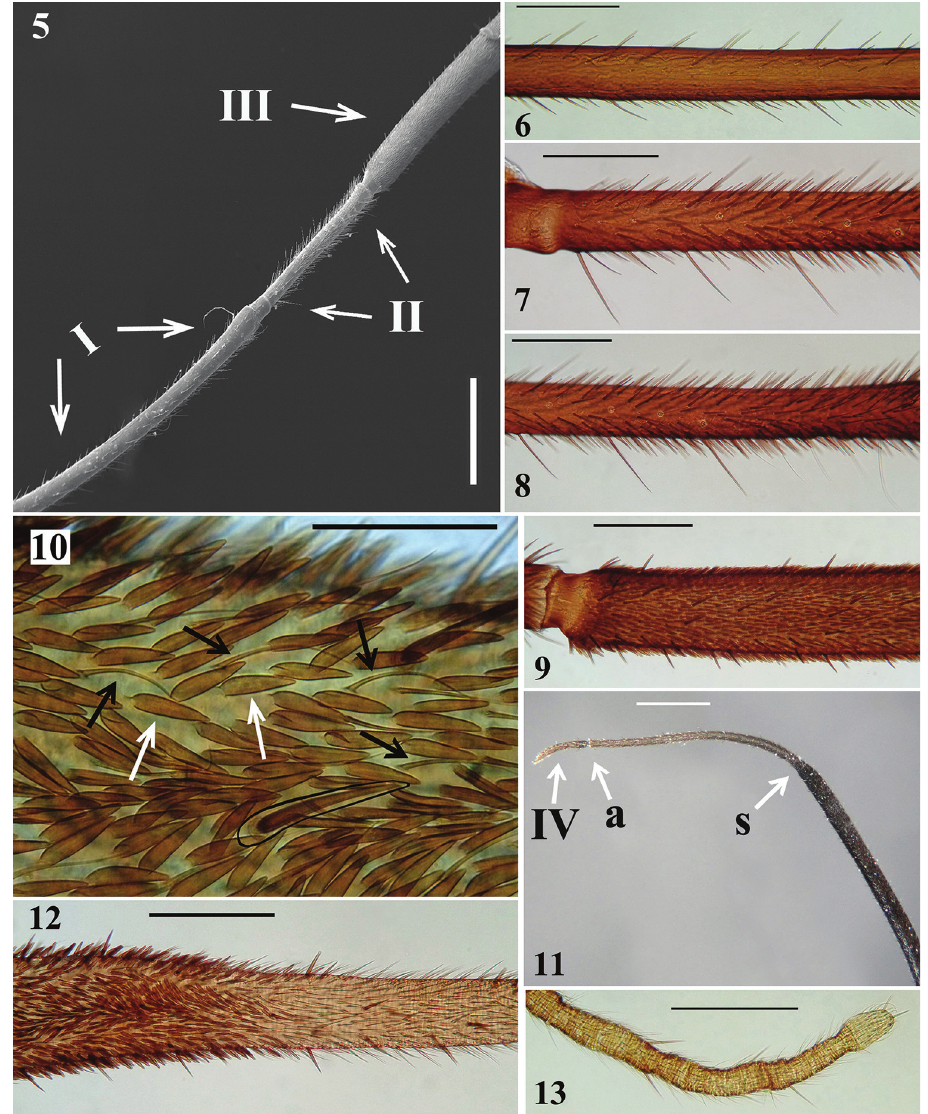
Figures 5–13. Parahiranetis salgadoi Gil-Santana, male antenna. 5 apical half of segment I, segment II and basal portion of segment III 6 segment I, midportion 7–8 segment II 7 basal half 8 distal half 9–10 segment III 9 basal portion 10 small area under higher magnification (a stiff darkened seta con- toured; black arrows point to thin pale setae; white arrows point to blackish stiff adpressed setae) 11 seg- ments III (distal half) and IV (basal half). ( s : point of clear separation between the thickened and thinner portions; a : articulation between segment III and IV; IV: fourth segment, partially broken) 12 segment III, region of the transition between the thickened and thinner portions 13 segment IV, distal half. Scale bars: 1.0 mm ( 5, 11 ); 0.3 mm ( 6–9, 12, 13 ); 0.1 mm ( 10